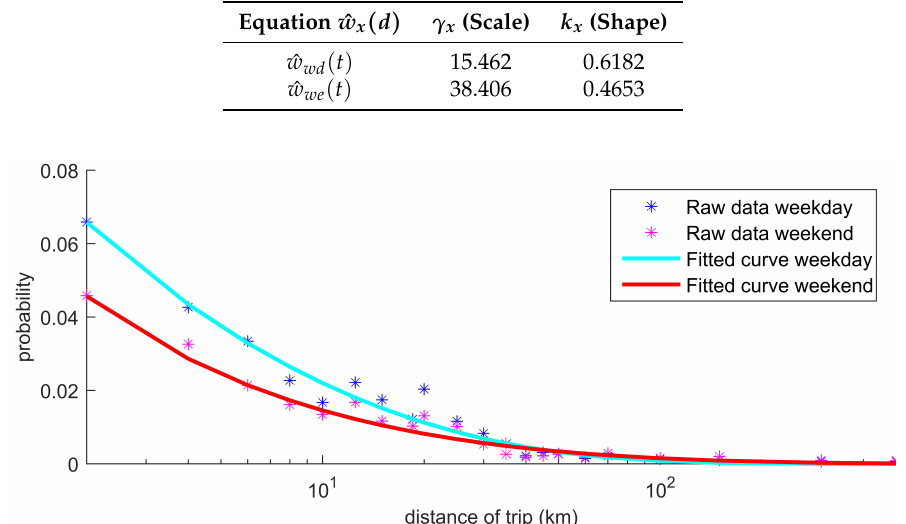
Figure 2. The probability of a trip being of a particular distance during a weekday, extrapolated into a Weibull distribution (RMS error: